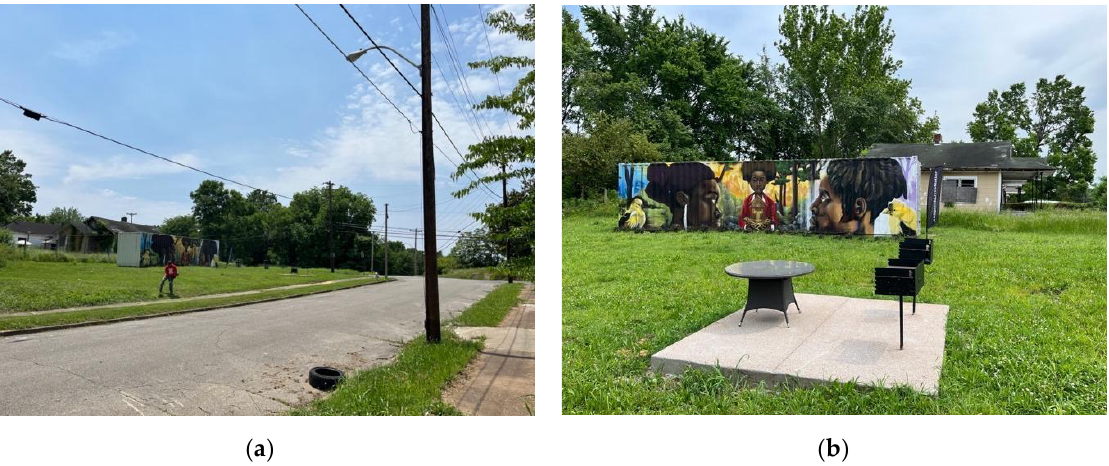
Figure 7. ( a ) MSH created a community park in a corner lot of a residential area near three of its tiny homes. ( b ) A grilling area in the community park is open for everyone who wants to use it. In the background, a mural on the side of a shipping container converted to a storage unit operates as a symbolic cultural marker for the historically black neighborhood.